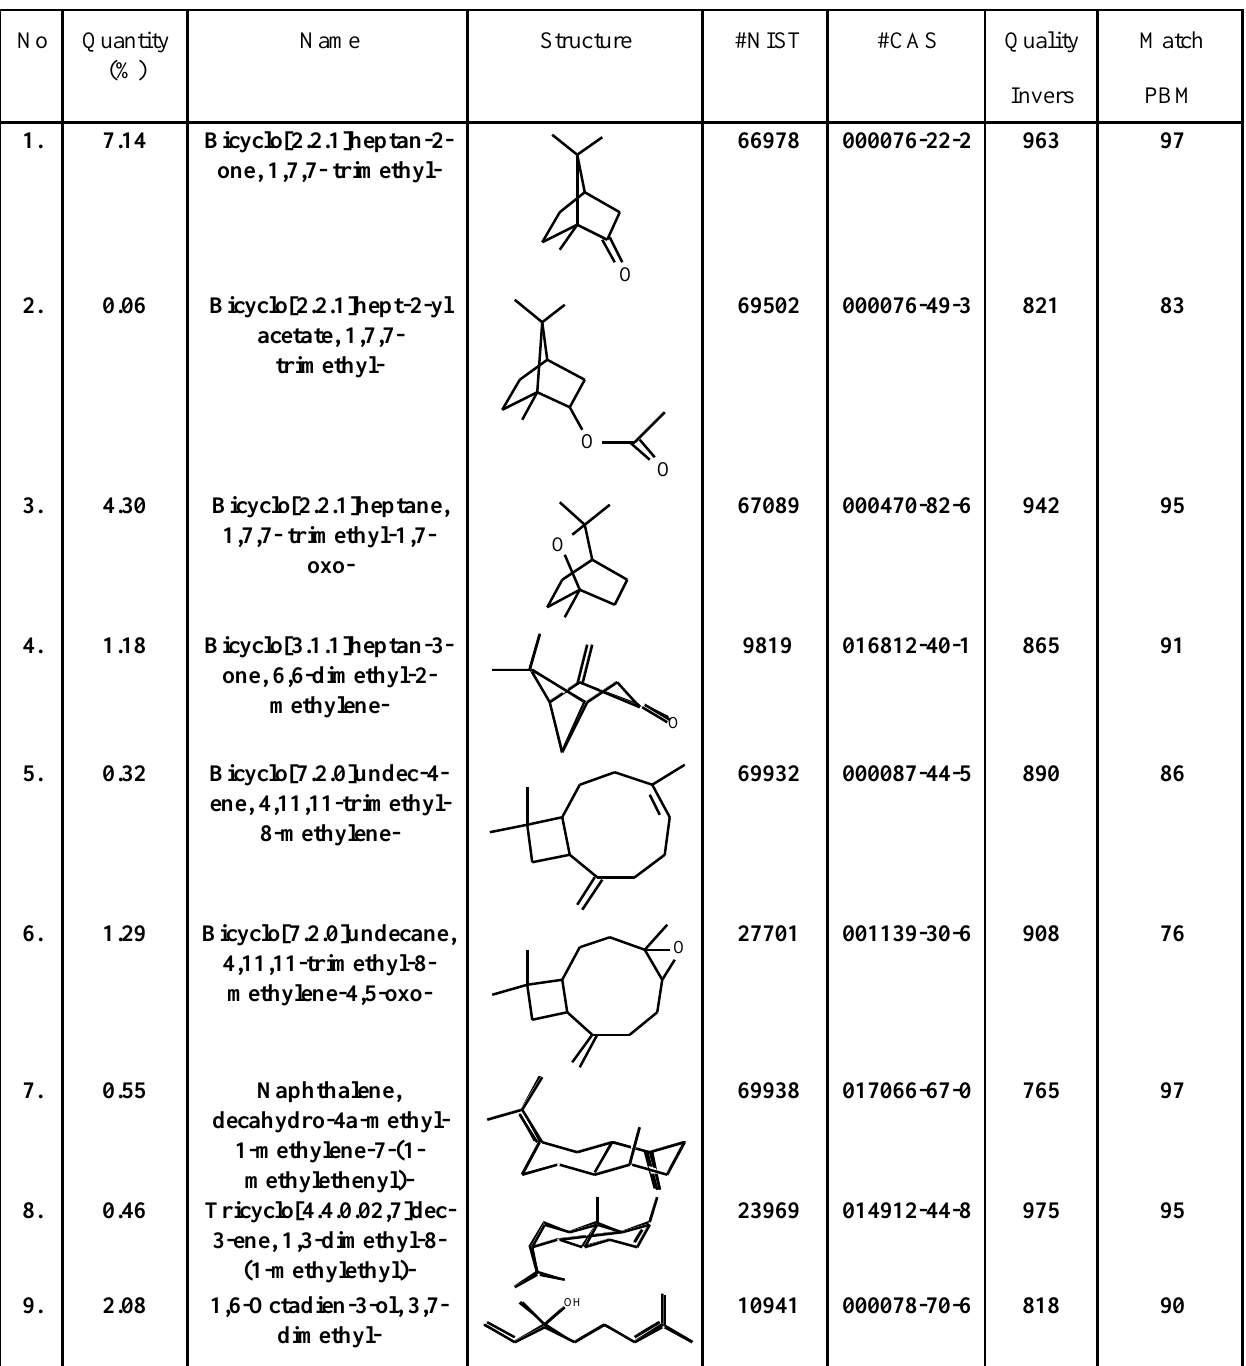
Table 1. The bicyclic compounds identified in cold plasma